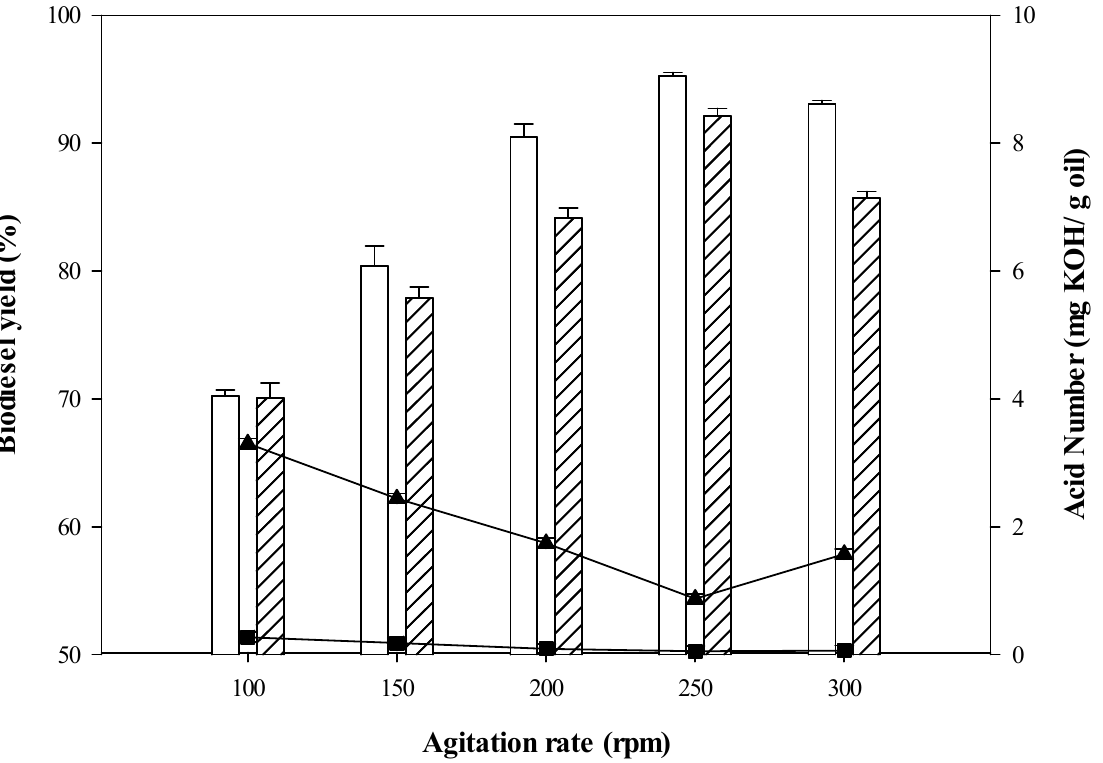
Figure 3. Biodiesel yield (%) as function of agitation rate (rpm) and acid number (mg KOH/g oil) (CPO biodiesel yield RPO biodiesel yield ▲ CPO acid number ■ RPO acid number).